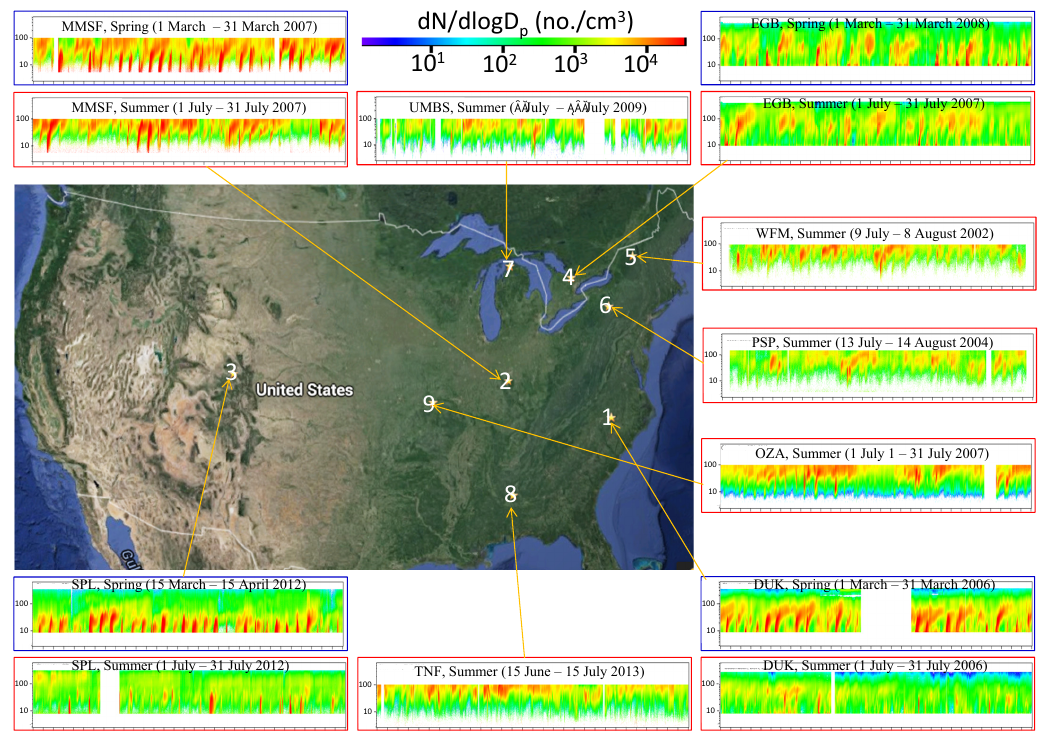
Figure 1. The locations of nine measurement sites in the forest areas in North America (see Table 1 for the names and references of the sites). Also shown are the particle size distributions measured in one spring month at sites 1–4 (with blue frames) and one summer month at all sites (with red